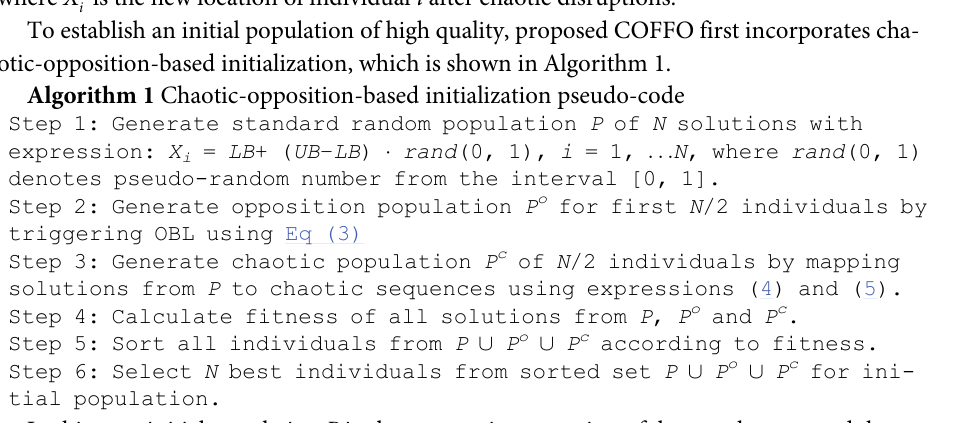
Algorithm 1 Chaotic-opposition-based initialization